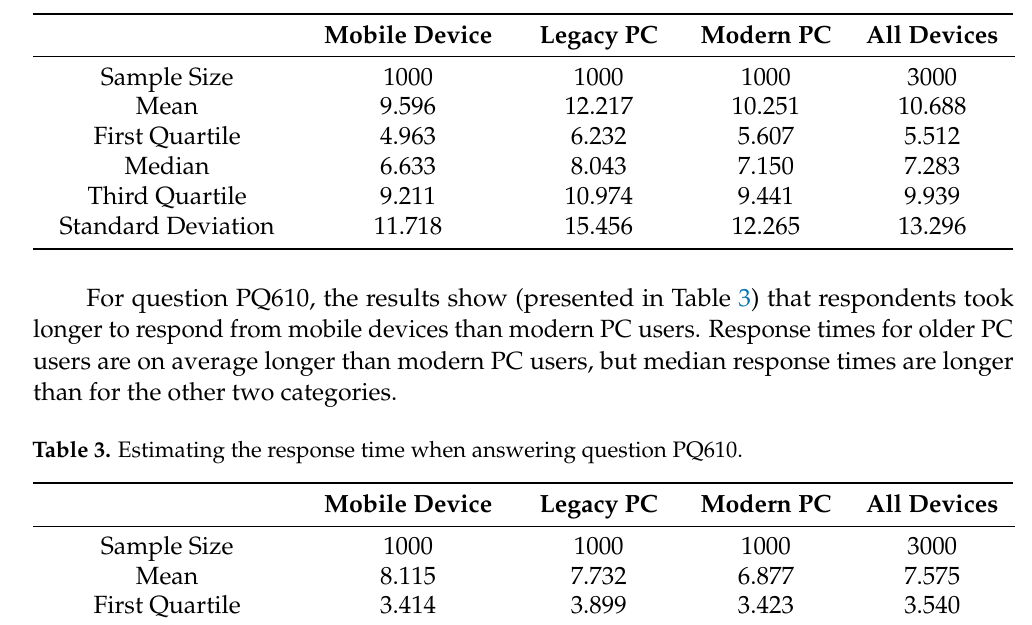
Table 2. Estimation of reaction time when answering a question PQ106-01.